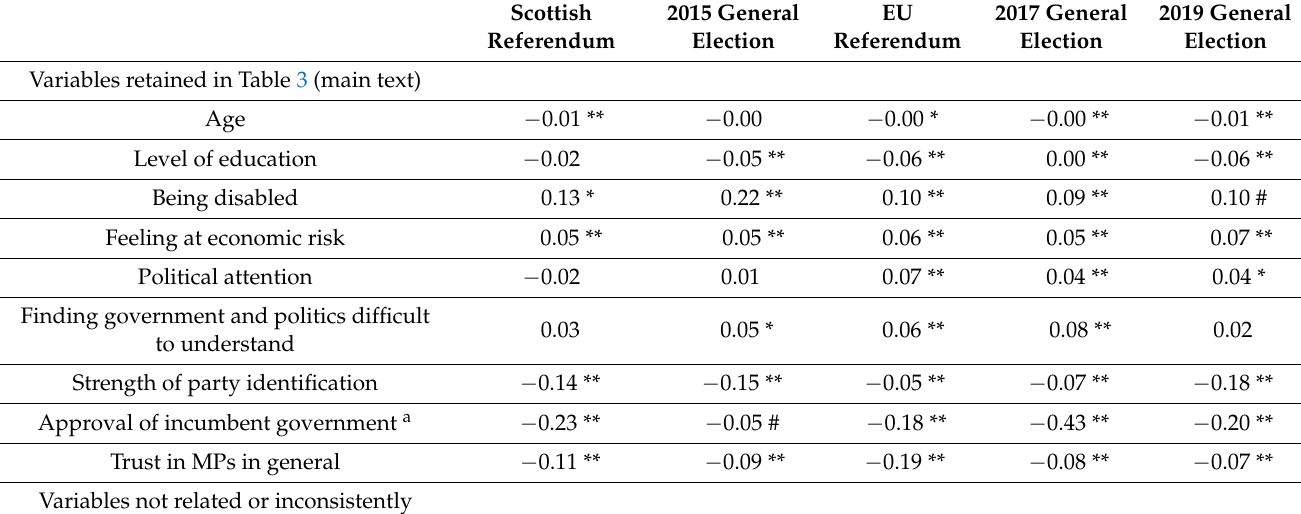
Table A3. Extension of Table 3 with variables not included in further explanatory analyses (unstan- dardised OLS